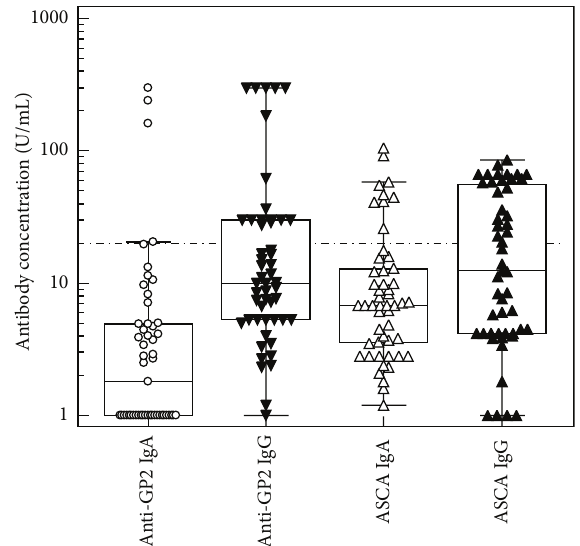
Figure 1: Comparison of anti-GP2 as well as ASCA IgA and IgG in 51 Italian patients with CD. The cutoff value of 20 arbitrary units (U/mL) recommended by the manufacturer of the commercial ELISAs (GA Generic Assays, Dahlewitz/Berlin, Germany) is indi- cated by a dotted